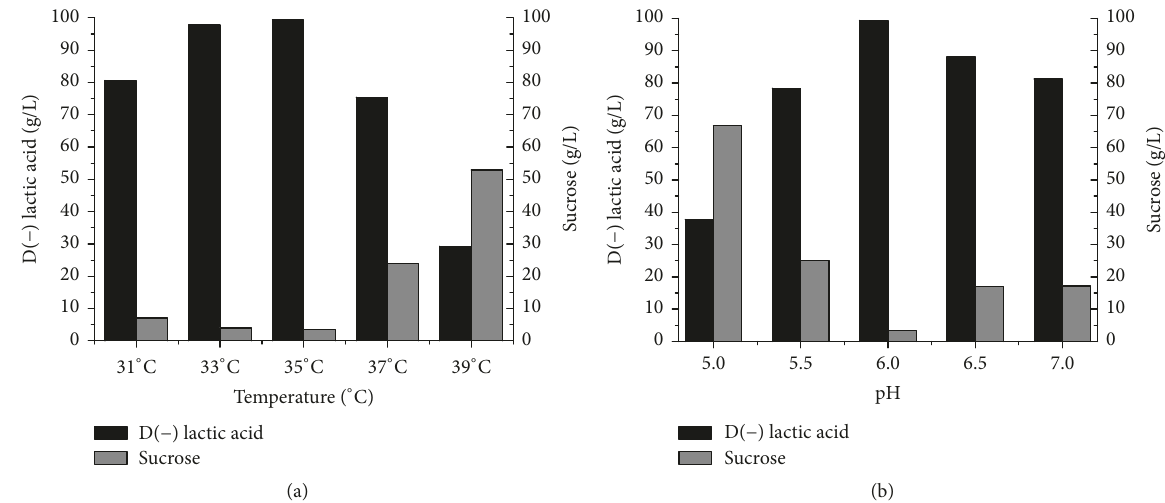
Figure 3: Effect of (a) temperature and (b) pH on D( − ) lactic acid production and sucrose consumption by S. nakayamae . Culture conditions: GYP modified medium (120g/L of crystallized sugar, 35 g/L of yeast extract, and 7.5 salt solution) with NaOH 10N as pH neutralizing agent. (a) GYP modified medium at pH 6.0, under 100rpm, with 10% inoculum; (b) GYP modified medium at 35 ∘ C, under 100rpm, with 10% inoculum.